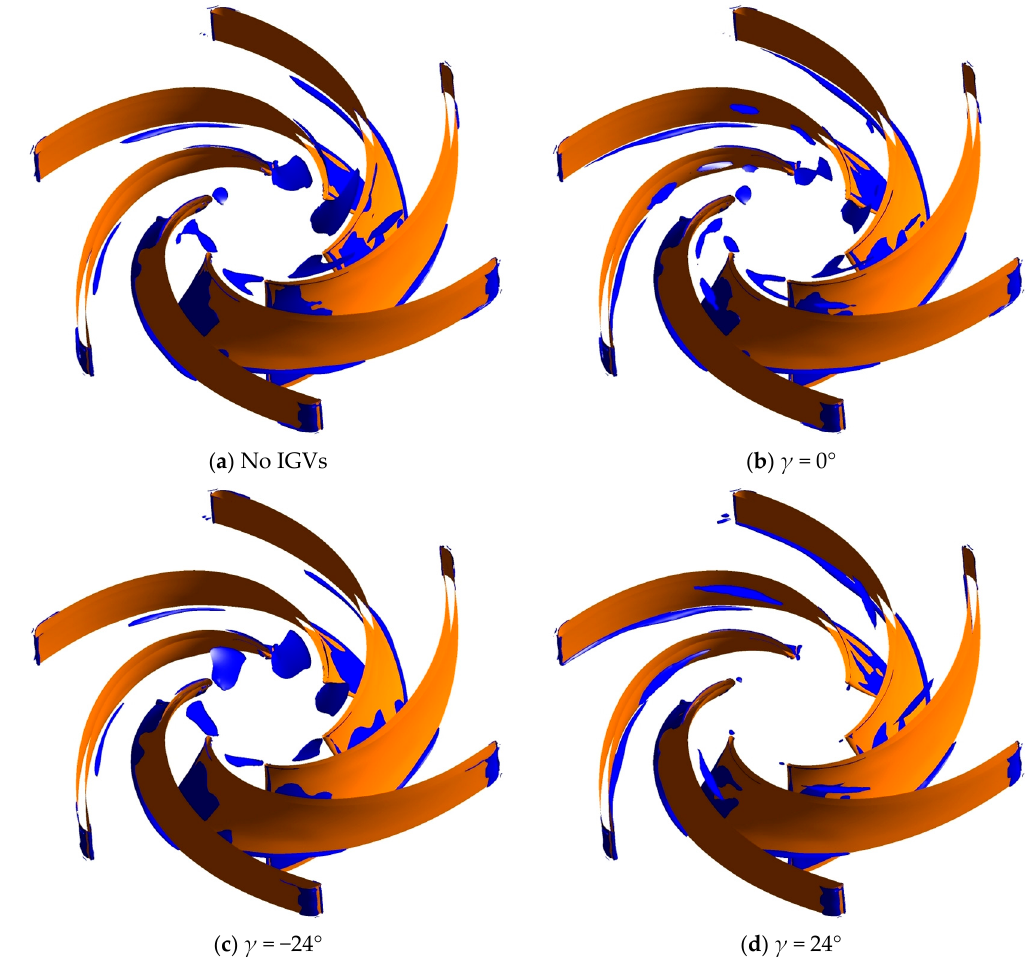
Figure 7. Isosurface of Q = 1.5 × 10 5 s − 2 in impeller passage for pumps without and with IGVs.